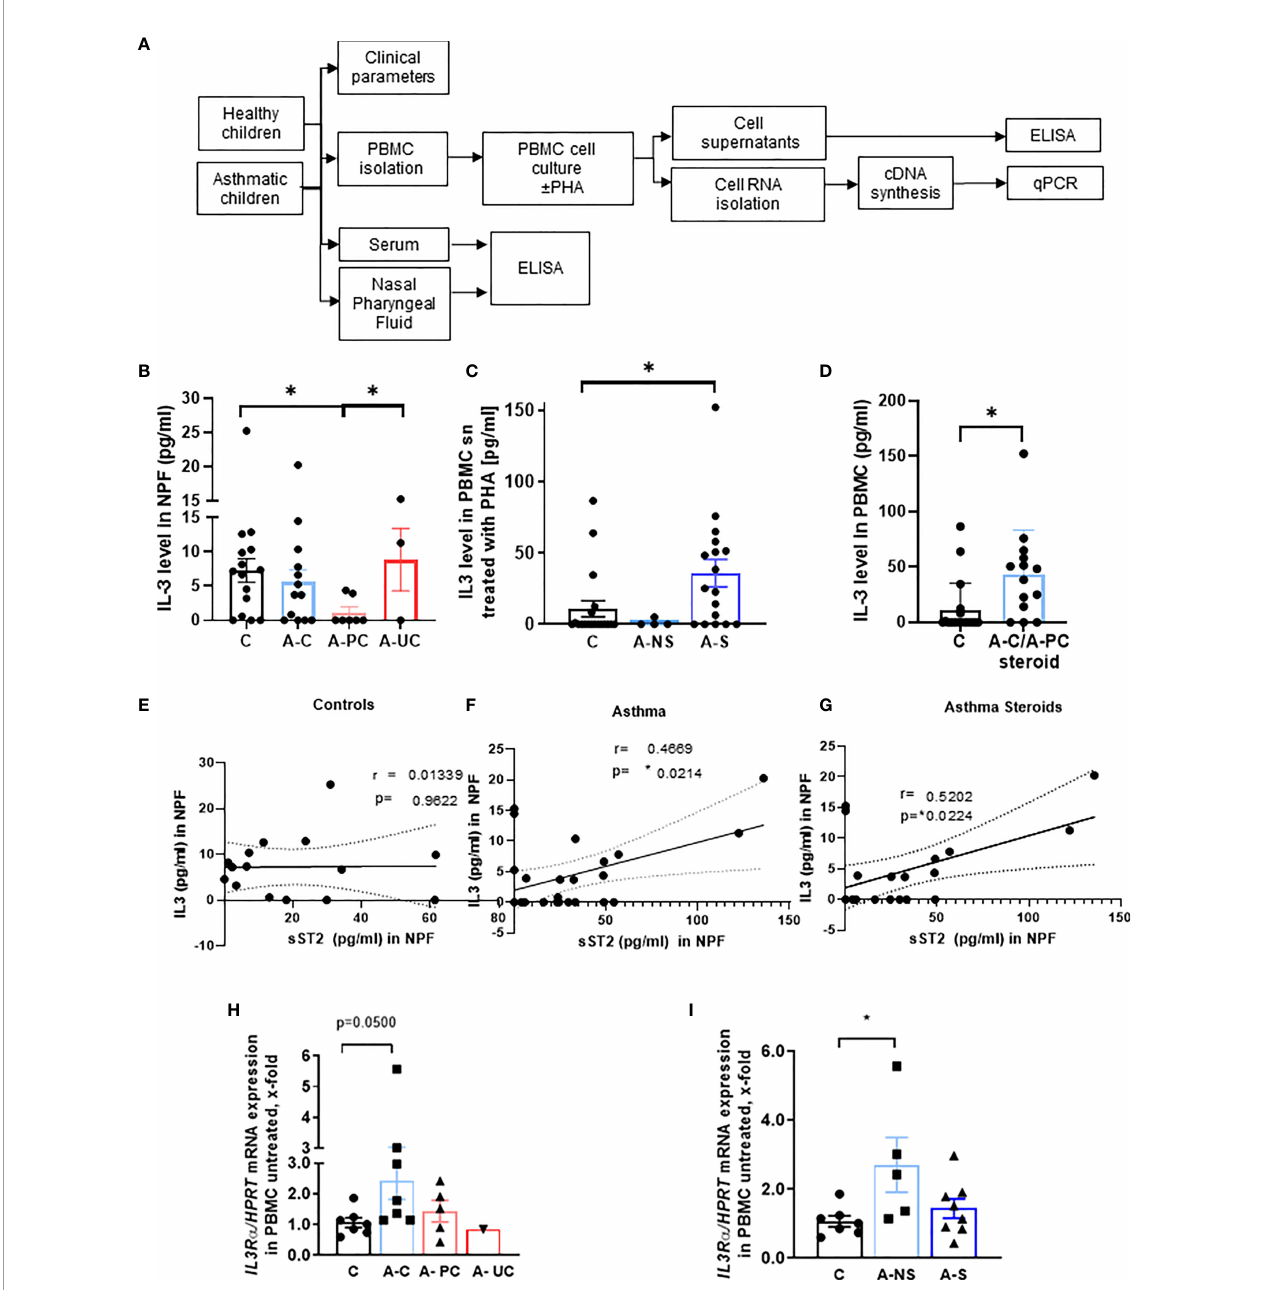
FIGURE 1 | Role of IL-3 in asthmatic patients. (A) Experimental design of the study PreDicta on the children cohorts analyzed in this study. (B) ELISA analysis of IL-3 levels in the nasopharyngeal fl uid (NPF) from control preschooler and asthmatic preschooler subgrouped into asthma controlled (A – C) , asthma partially controlled (A-PC), and asthma uncontrolled (A-UC) (GINA 2009) (n = 15, 13, 7, 3). (C) ELISA analysis of IL-3 levels in the supernatant from peripheral blood mononuclear cells (PBMCs) isolated from healthy control and asthmatic children and cultured with phytohemagglutinin (PHA) for 24 h. Asthmatic children were subgrouped in accordance to the medications used: non-steroids (NS) and steroids (S) (n = 19, 4, 18; p = 0.028). (D) Analysis (shown in panel C ) considering steroid-treated asthmatic children controlled and partially controlled (n = 19, 14). (E – G) IL-3 in NPF from control (E) (n = 15) and asthmatic preschoolers (F) (n = 24) were correlated with the correspondent sST2 in NPF. A signi fi cant positive correlation was maintained when only the asthmatic children treated with steroids were correlated (G) (n = 19) (Pearson ’ s correlation test). (H) IL3Ra/HPRT mRNA expression in PBMCs of controls and asthmatic children subgrouped into asthma controlled (A – C) , asthma partially controlled (A-PC), and asthma uncontrolled (A-UC) (n = 7, 7, 5, 1) and (I) in asthmatic children treated with (A-S) or without steroids (A-NS) at the baseline visit (n = 7, 5, 8). Data are presented as means ± SEMs. Two-tailed Student ’ s t -test or Kruskal – Wallis test was used to calculate statistical signi fi cance. *p ≤